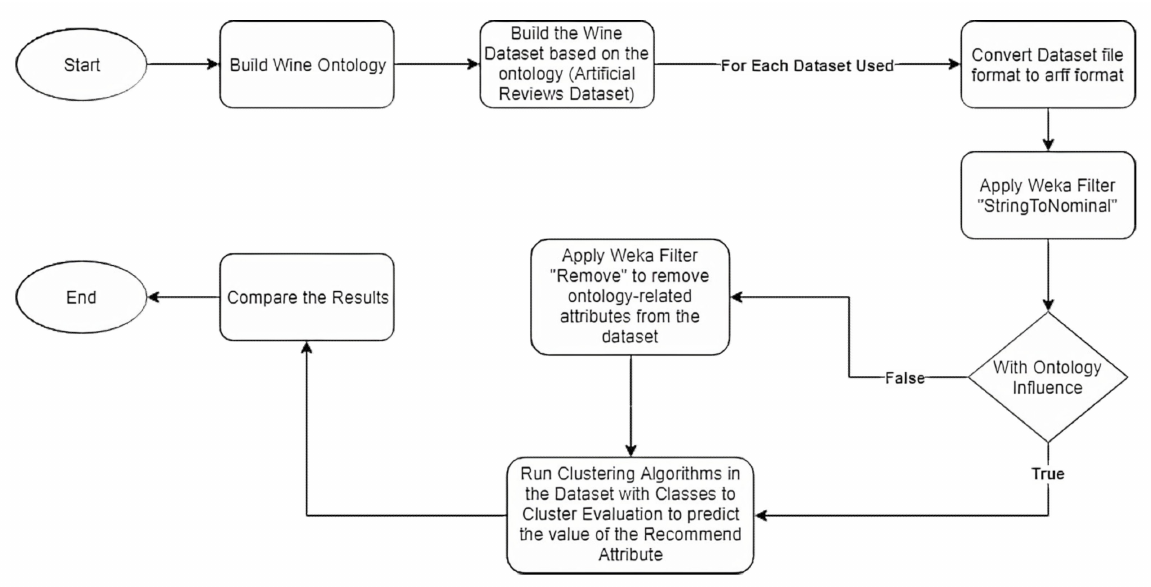
Figure 5. Methodology